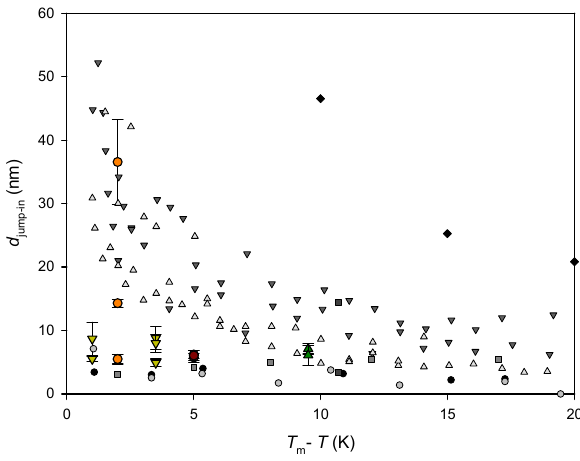
Figure 6. AFM jump-in distances obtained with the EC, in color symbols. For comparison, results of QLL thicknesses obtained from literature with similar techniques are plotted in the same figure. Symbols for results by other authors are the same as in Fig.